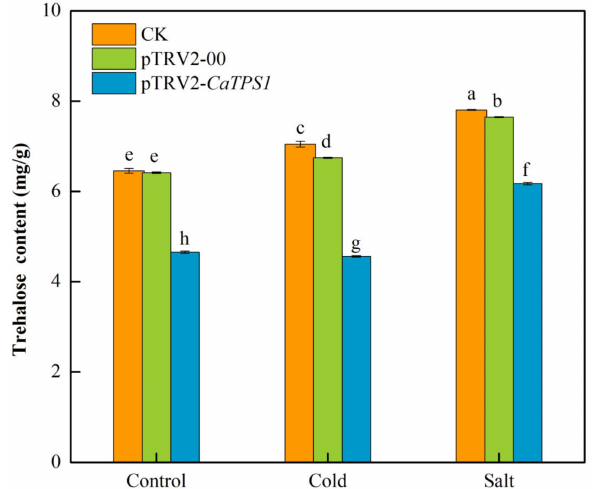
Figure 6. The trehalose content under cold and salt stresses. Each value is shown as the mean ± standard error of three biological replicates, and the multiple comparison test for each gene was presented. Different letters stand for significant differences between CK, TRV2-00, and TRV2- CaTPS1 plants (Duncan’s test, p < 0.05).